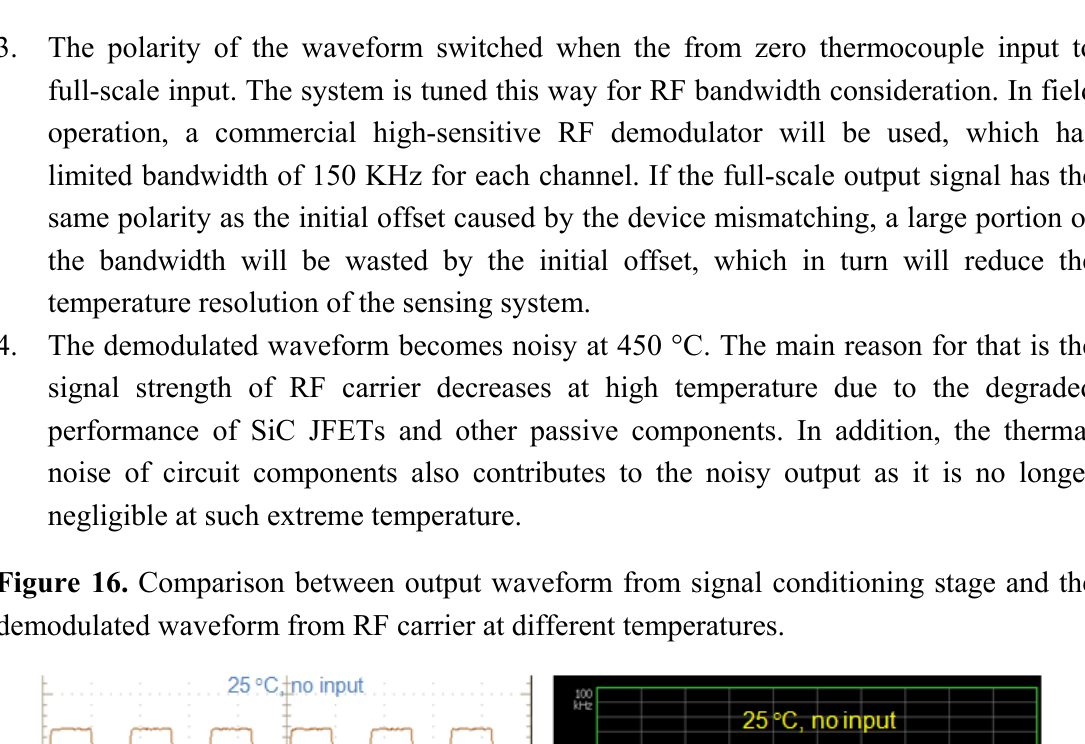
Figure 16. Comparison between output waveform from signal conditioning stage and the demodulated waveform from RF carrier at different temperatures.